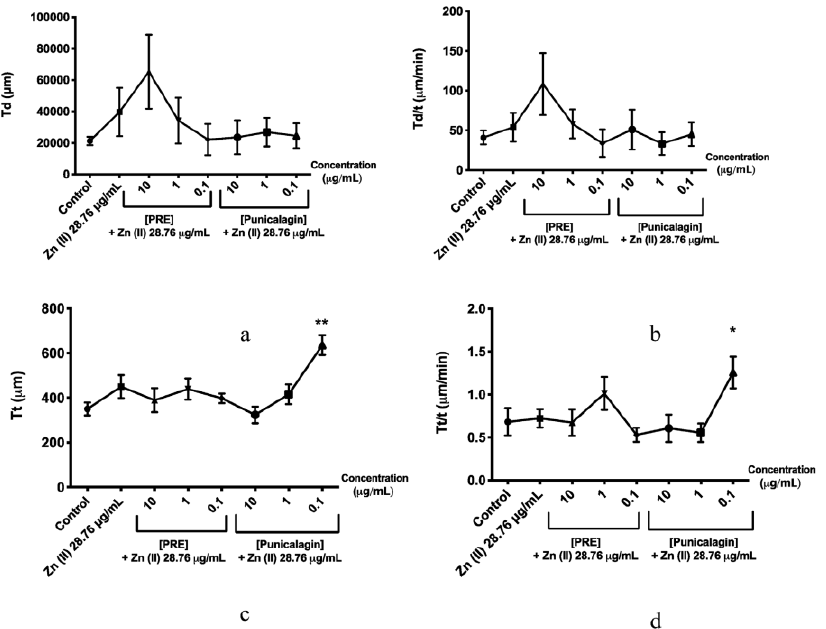
Figure 6. E ff ects of PRE (0.1–10 µ g / mL) and punicalagin (0.1–10 µ g / mL) in combination with 28.76 µ g / mL (0.1 mM) Zn (II), on human gingival fibroblast scratch wound migration parameters, over 48 h. ( a ) Cell displacement (Td), ( b ) overall velocity (Td / t), ( c ) distance travelled (Tt), and ( d ) migration speed (Tt / t). Values are presented as the mean ± SEM ( n = 3, * p < 0.05, ** p <